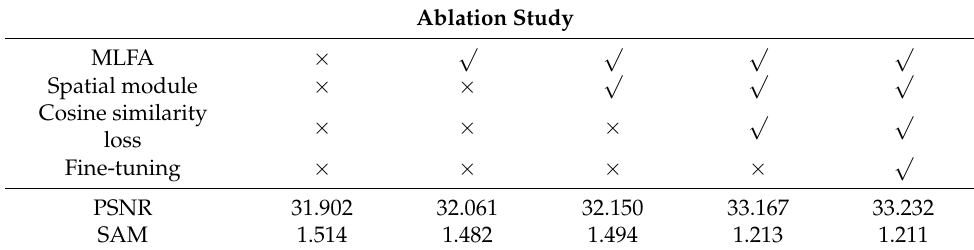
Table 4. Ablation experiments of SSRN on the WDCM